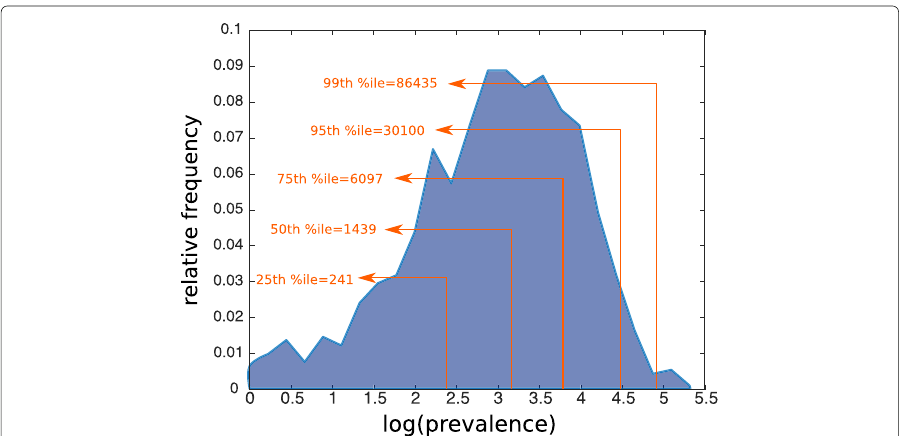
Fig. 2 Distribution of disease prevalence. The logarithm of the prevalences is normal-like, but the Kolmogorov-Smirnov test rejects the normality hypothesis